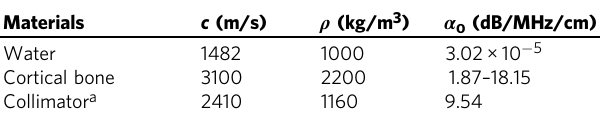
Table 3 Acoustic parameters for numerical